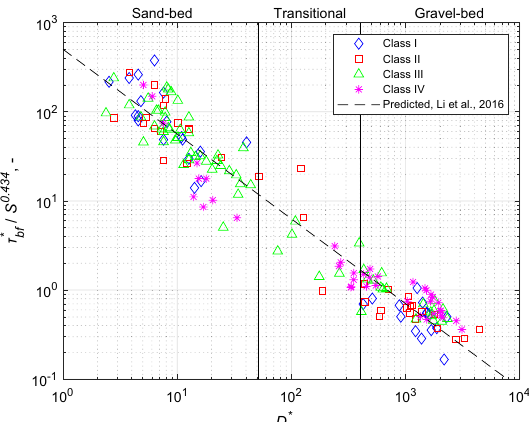
Figure 1. Regression relation of Li et al. 36 (dashed gray line) and τ ∗ bf , / S 0.434 D ∗ , as well as data for the study river sections used here. The cases of the densest woody vegetation appears in purple (Class IV) and the tree- and shrub-free case is in blue (Class I), while the two intermediate states are in red (Class II) and green (Class